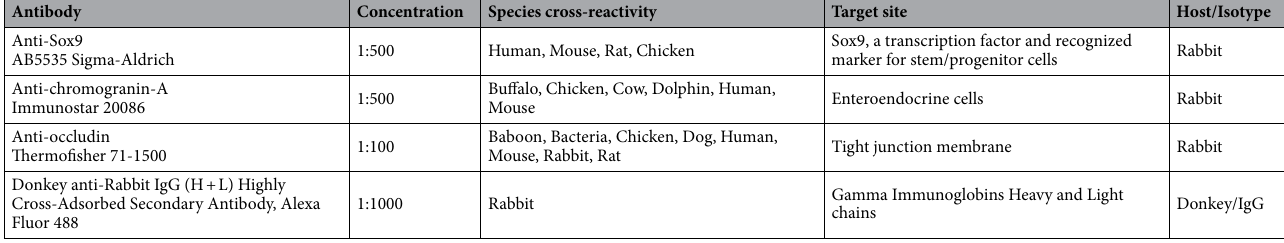
Table 1. Characteristic of the used